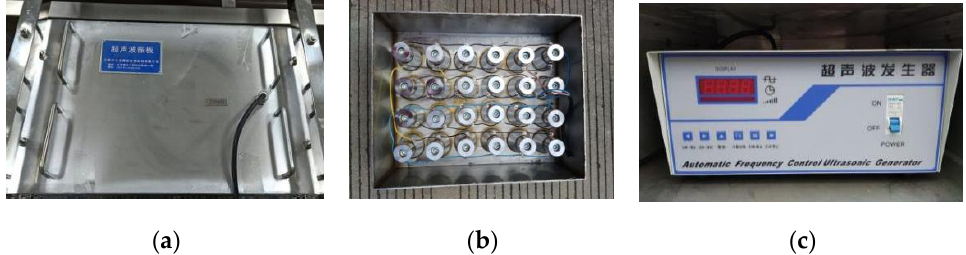
Figure 6. Ultrasonic vibration plate and generator. ( a ) Ultrasonic vibration plate; ( b ) Ultrasonic vibrator. ( c ) Ultrasonic generator.